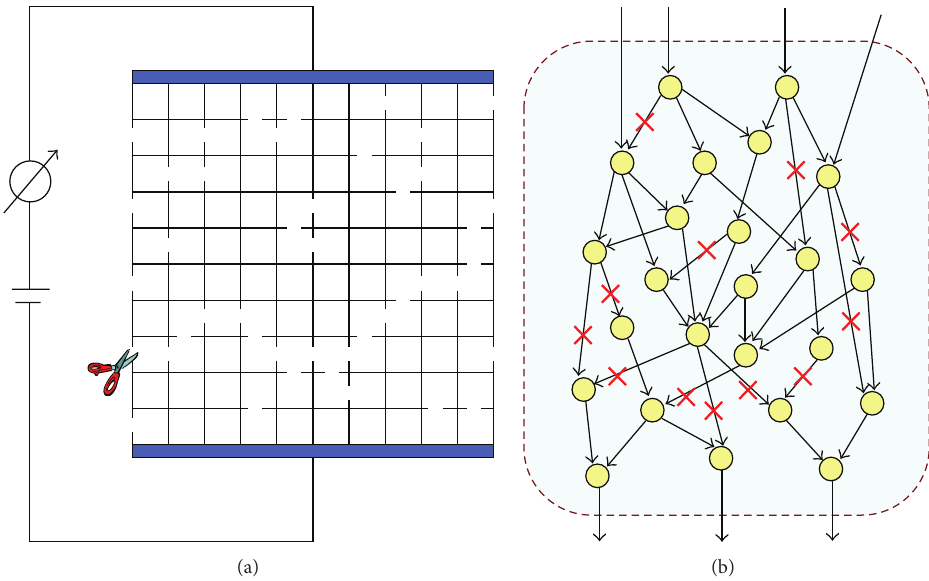
Figure 1: (a) Schematic representation of the two-dimensional bond percolation experiment. Conductivity of a steel-wire mesh is studied during the procedure of cutting wires (bonds) in the mesh. The goal is to find an average number of bonds which should be removed until the mesh conductivity vanishes to zero. (b) Schematic representation of our procedure. In each iteration of the modeling, a reaction is knocked out until no reaction can carry a nonzero flux in steady-state conditions.